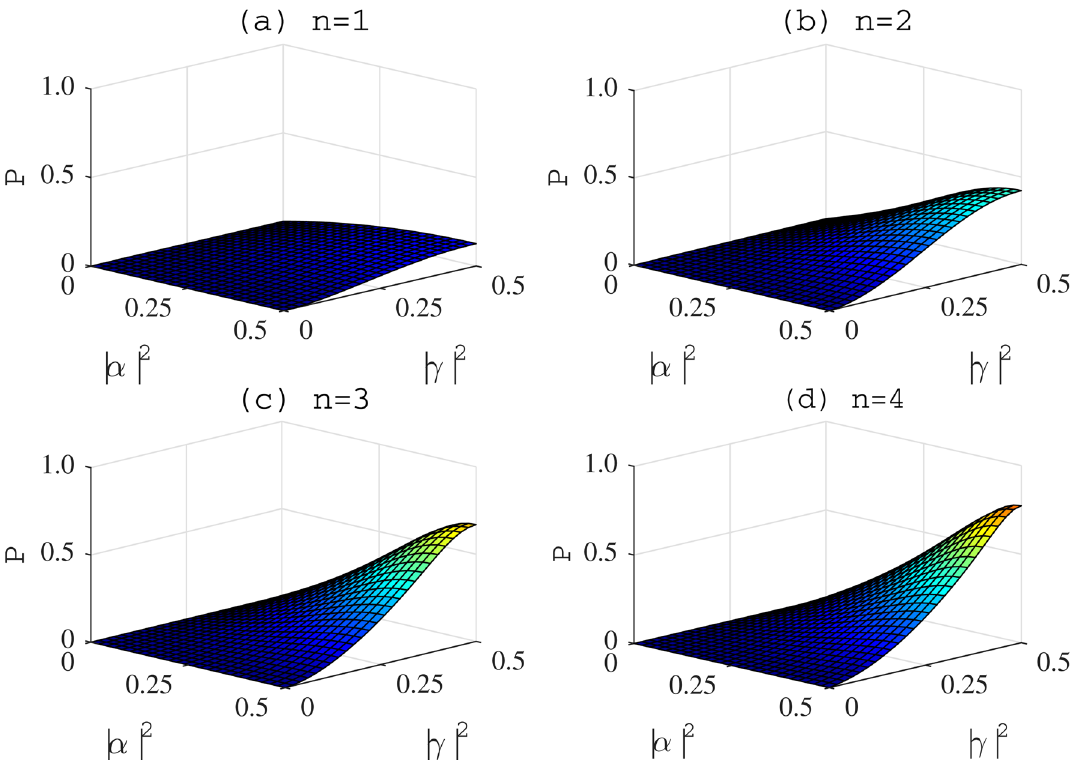
Figure 5. The success probability P of our hyper-ECP for two-photon six-qubit systems in an arbitrary partially hyperentangled Bell state. The parameters of the arbitrary partially hyperentangled Bell states are chosen as i ( i 1, 2, 3, 4 ) is the iteration number. Different figures correspond to the schemes with different γ ǫ . n = = | | = | | number of